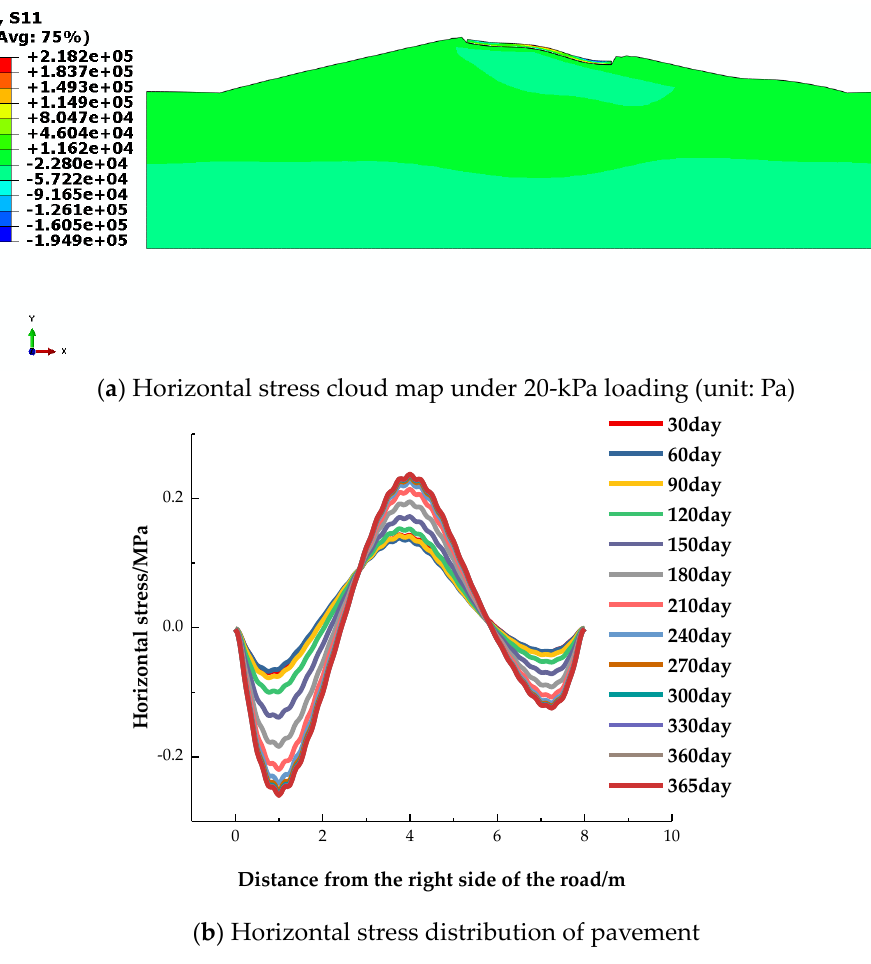
Figure 13. Horizontal stress of pavement.